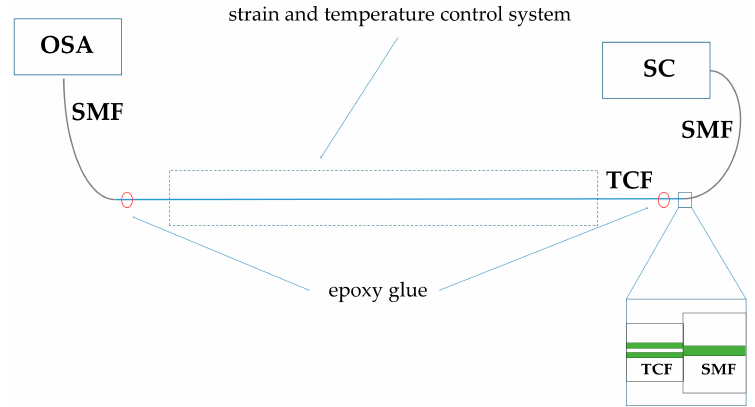
Figure 2. Experimental setup for measuring the elongation and temperature response of the SMF–TCF–SMF interferometer. SC: supercontinuum; SMF: single mode fiber; TCF: twin core fiber; OSA: optical spectrum analyzer. On the inset, the splice between the SMF and TCF is shown schematically. Cores in both fibers are indicated by green color.